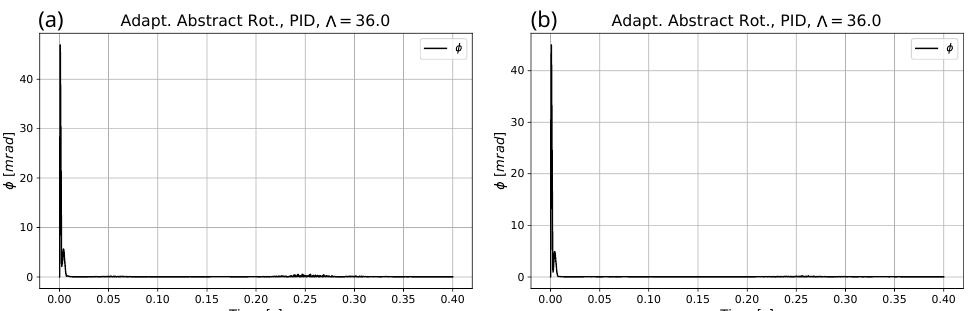
Figure 13. The optimal forces without force limitation and without the initial transient. ( a ) For set 1. ( b ) For set 2.